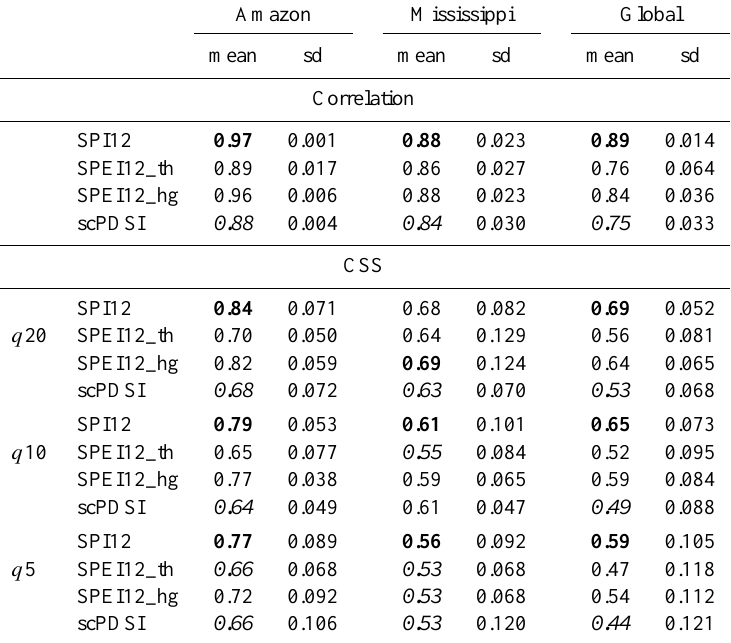
Table 5. Correlation and CSS between various meteorological drought indices and the reference standardized runoff index (SRI12) in the CNRM-CM5 model. Scores were calculated for average and detrended indices over the Amazon and Mississippi watersheds, as well as averaged over the globe on the basis of grid-cell rather than basin-scale indices (long: − 180 ◦ E, + 180 ◦ W; lat: − 60 ◦ S, + 60 ◦ N). The CSS was calculated using the 5th, 10th and 20th percentiles of the annual drought index distribution. Mean and standard deviation (sd) based on our five-member ensemble of 1850–2100 simulations are shown. Highest (bold) and lowest (italics) mean values are also